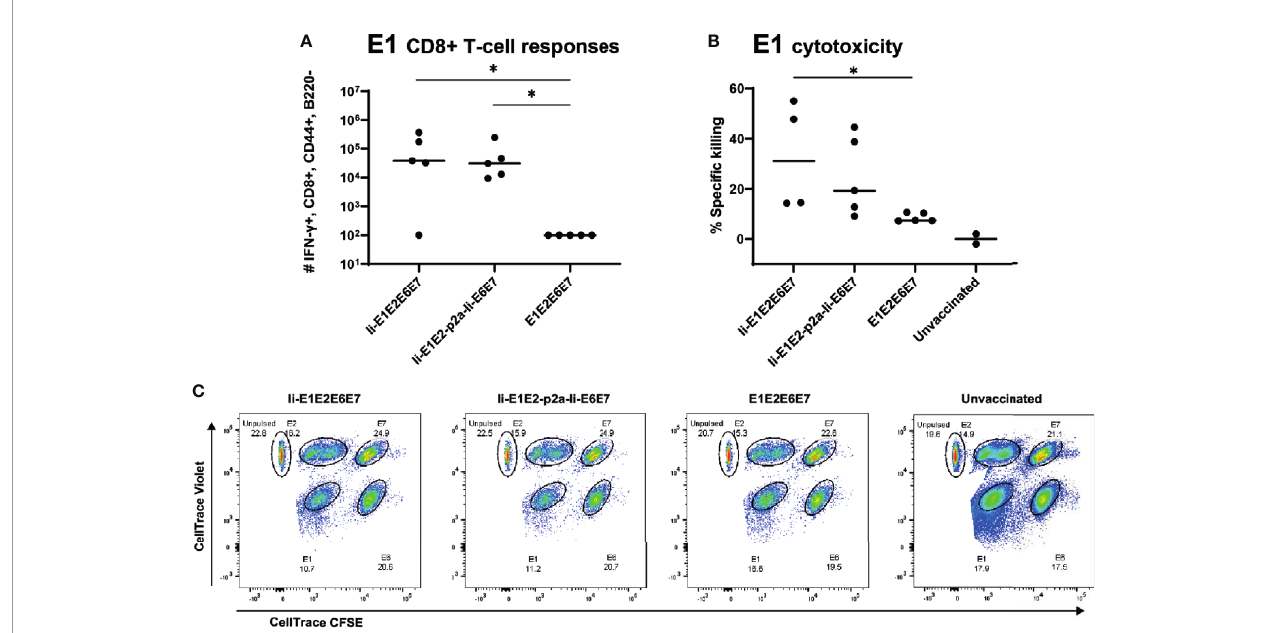
FIGURE 6 | Immune responses in inbred mice and in vivo cytotoxicity. Naïve BALB/c mice were immunized with rAd vectored vaccine encoding the indicated MfPV3 early antigens. 14 days post vaccination, immune responses were analyzed by ICS (A) or in vivo cytotoxicity regarding speci fi c killing of E1-peptide pulsed cells (B) . Each symbol represents one mouse. Two unvaccinated mice were included as negative controls. (C) Representative plot of in vivo cytotoxicity. *p <